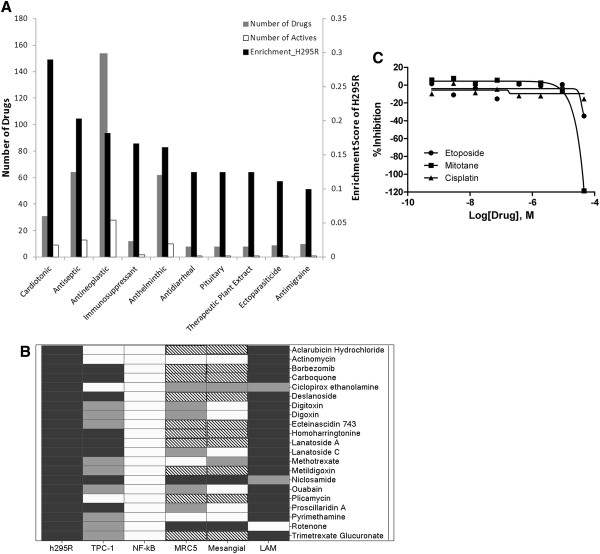
A) Enrichment analysis of screened active compounds by therapeutic category.B) Drug activity profile across different cell lines and primary cell culture of 21 active drugs in H295R cells. Black box indicates active compound, grey box indicates compound with inconclusive activity, white box represents inactive compounds, and the compounds that were not tested are labeled in stripe. The criteria for compound activity are described in Data Analysis section. TPC-1: papillary thyroid cancer cell line, NF-kB: ME-180 human cervical carcinoma cell line, MRC5: normal human fetal lung fibroblasts, Mesangial: human kidney glomerular mesangial cell line, LAM: lymphoangioleiomyosis cell line (LAM, a rare lung disease that results in a proliferation of disorderly smooth muscle growth). C) Dose–response curve of NCI-H295R treated with cisplatinum, etoposide and mitotane.